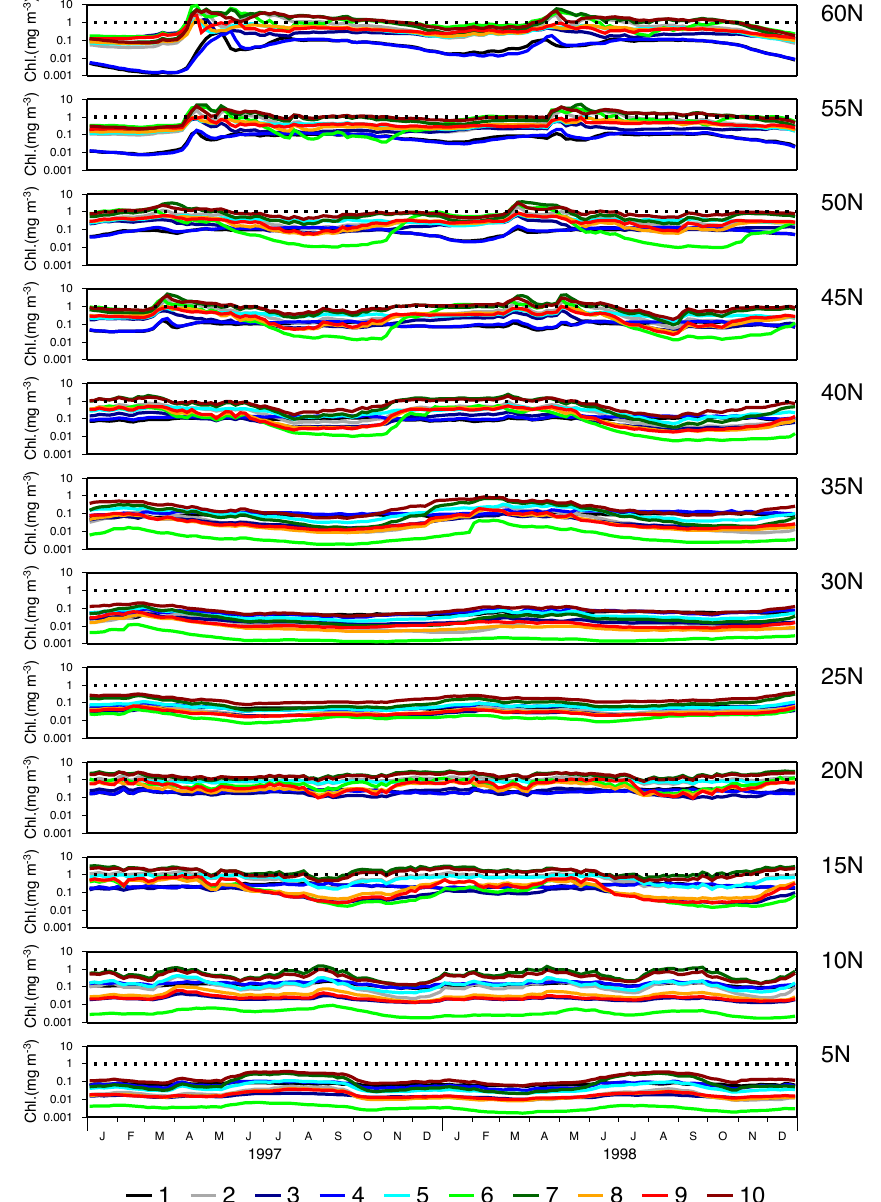
Figure 3. Five-day mean surface chlorophyll output from 3-D NEMO-MEDUSA simulations for the 10 parameter vectors in Table 2, colour coded by Parameter Set